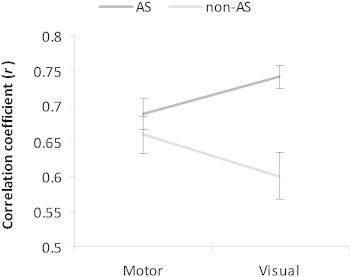
Correlation coefficients displayed for each group for the motor and visual ROIs. Error bars represent standard errors.